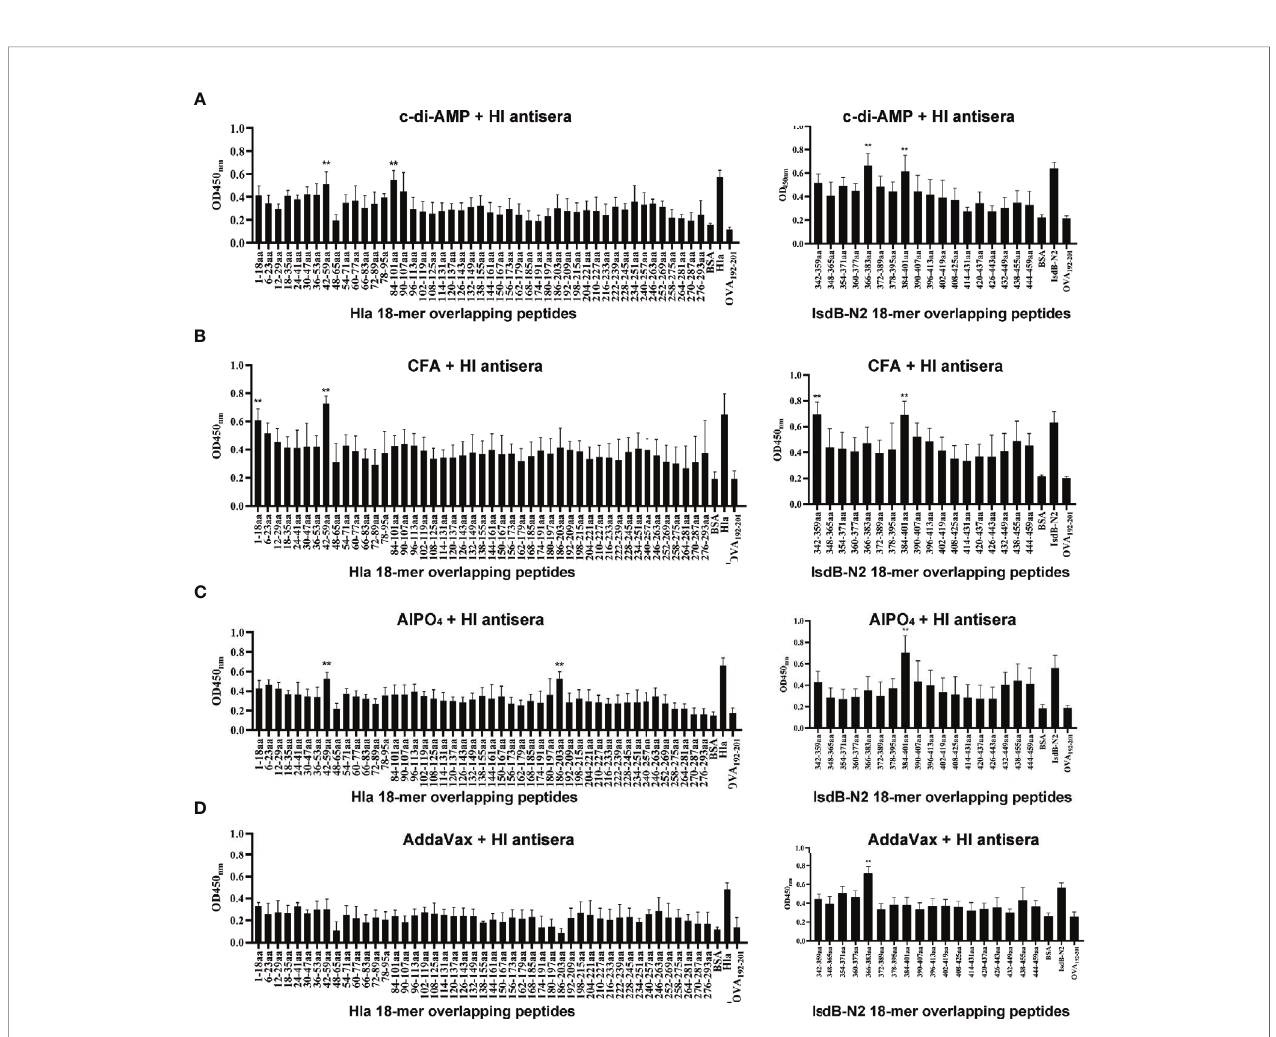
FIGURE 3 | B cell epitope mapping in Hla or IsdB by ELISA. To identify the immunodominant epitopes on Hla or IsdB, microtiter plates were coated with synthetic overlapping peptides that spanned the entire length of the Hla or IsdB. OVA 192 – 201 was used as a negative control peptide. Then, serum samples from BALB/c mice immunized with HI plus c-di-AMP (A) , CFA (B) , AlPO 4 (C) and AddaVax (D) adjuvants were used as primary antibodies (n=10). The absorbance was read at 450 nm. The raw O.D. values shown were obtained using serum from three independent experiments assayed concurrently. Each bar represents the average OD observed for all 10 mice in each group. Data are represented as the means ± SEM. Probability values of p < 0.01 were considered signi fi cant and are denoted by an asterisk (**).